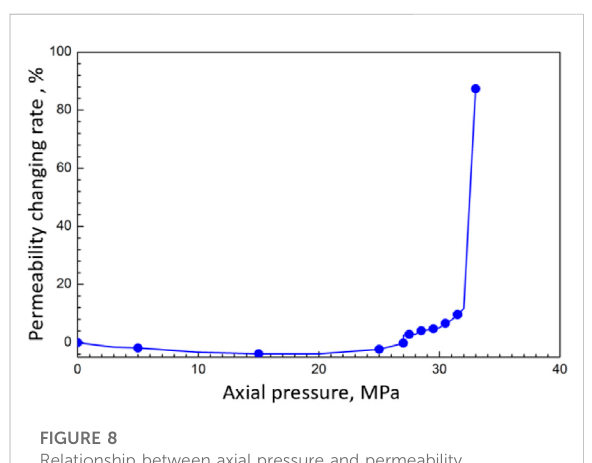
FIGURE 8 Relationship between axial pressure and permeability changing rate.